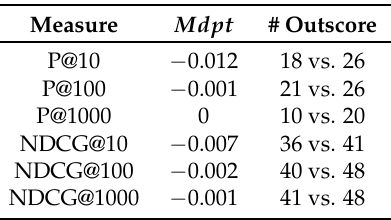
Table 21. T2: Porter/DirichletLM+QE+RF run vs. RR fusion of DirichletLM+QE+RF model with the four